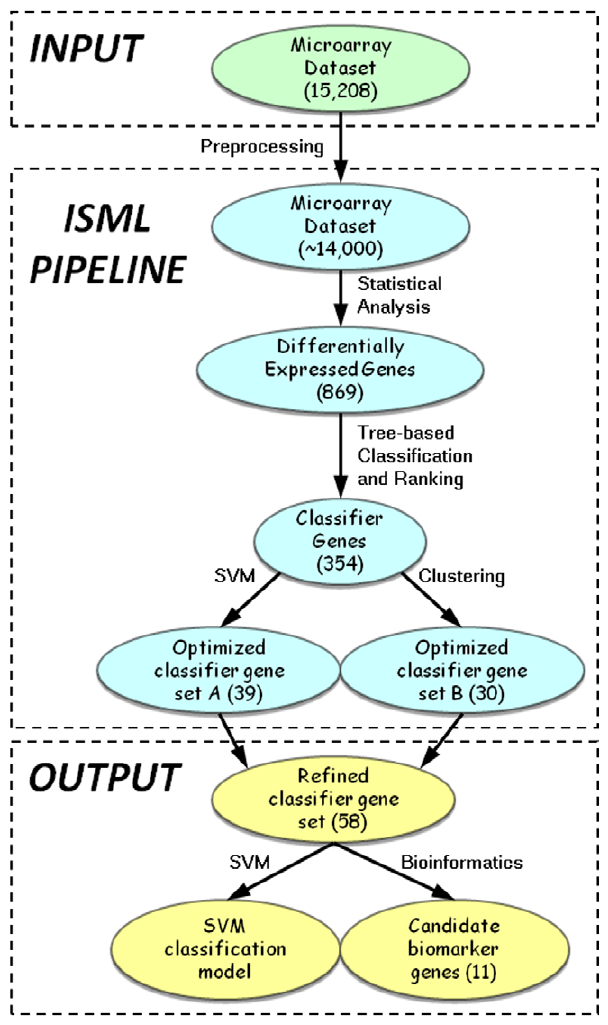
Figure 1. Overview of the integrated statistical and machine learning (ISML) pipeline. The pipeline illustrates the analytical procedure that integrates statistical analysis with supervised machine learning and unsupervised clustering as described in Materials and Methods . Numbers in brackets indicate the amount of genes remaining (also see Results